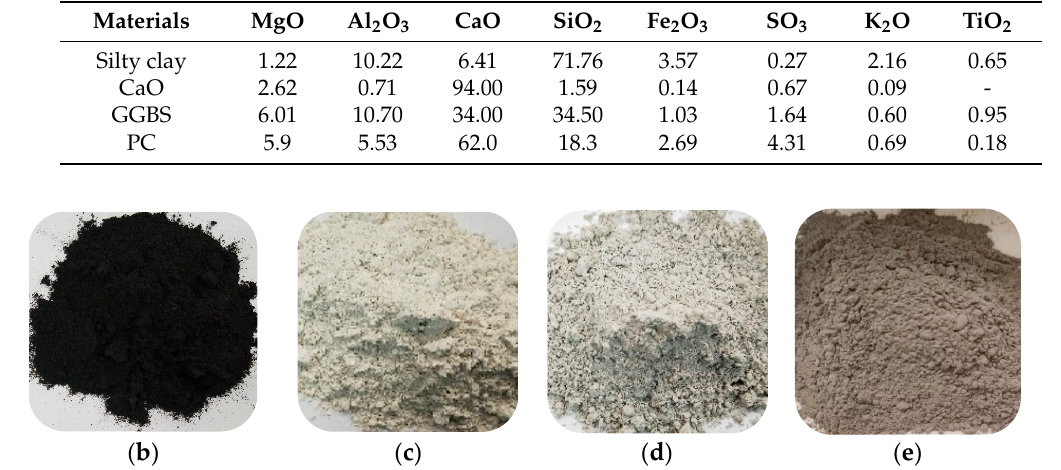
Table 2. Main chemical compositions of the materials.